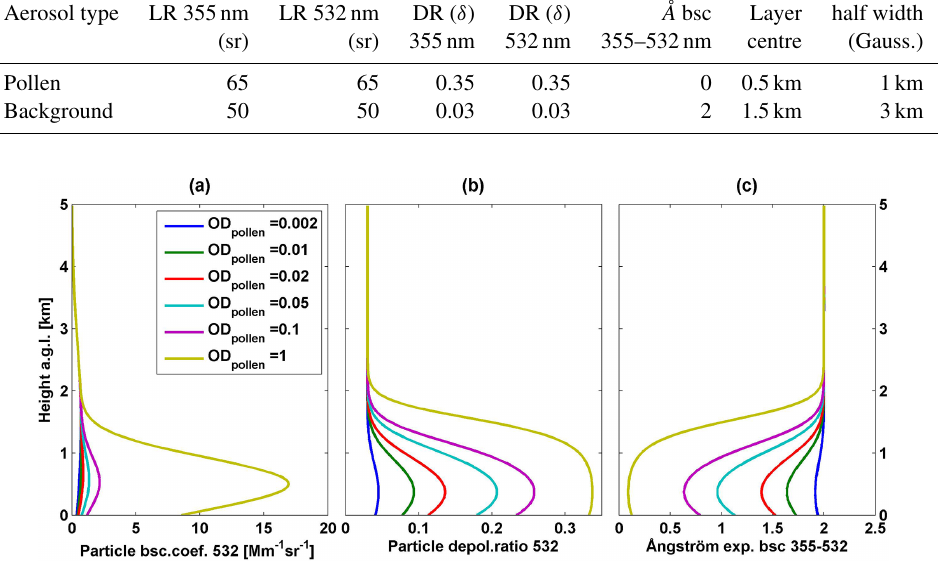
Table 1. Parameters of pollen and background aerosol layers as input for the direct model. LR: lidar ratio, DR: depolarization ratio, Å bsc: backscatter-related Ångström exponent. A Gaussian distribution is applied for each layer, with the layer centre and half width given.